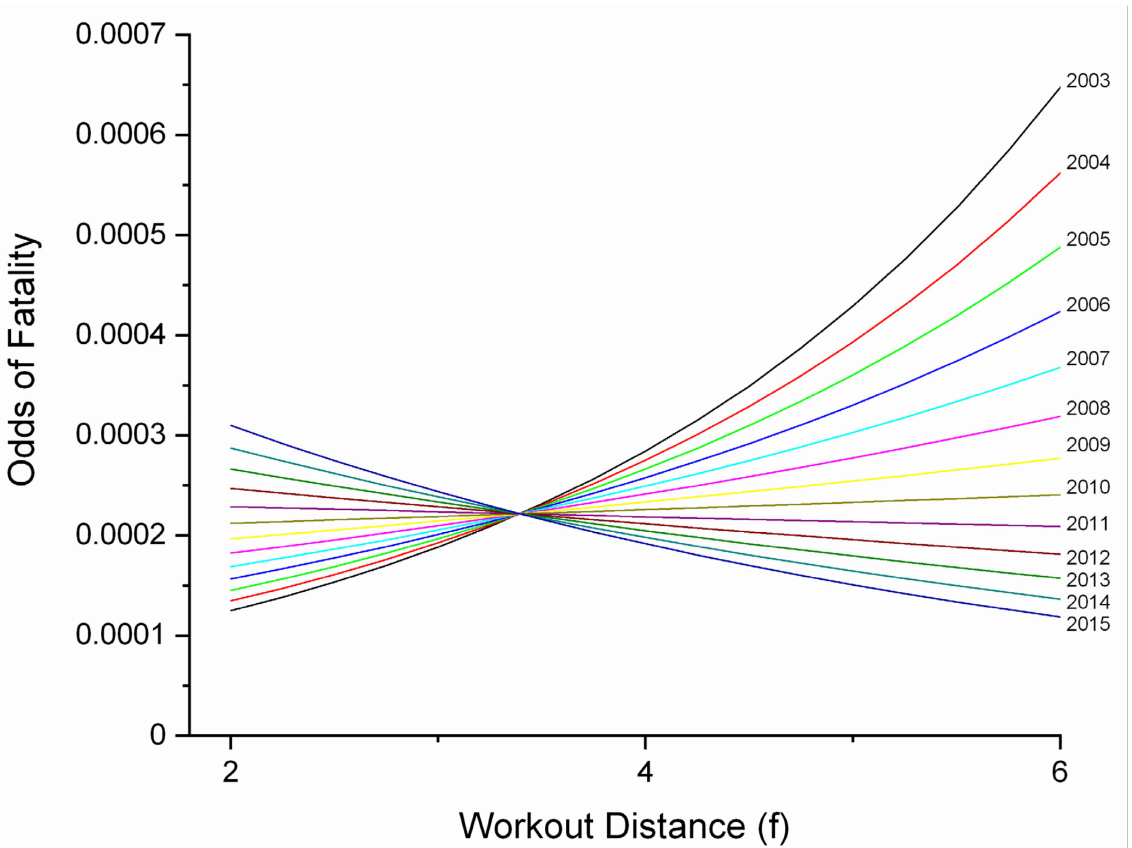
Figure 5. Odds of fatality by year (YEAR) and workout distance (DIST) for Ontario Thoroughbred racehorses for the period 2003–2015, unit of interest—workout work-event. The graph describes the interaction DIST*YEAR identified during multivariable logistic regression modelling of workout event fatalities. Fatality increased with workout distance early in the study period, but this effect disappeared by 2010, after which there was a reduction in fatality with increasing distance. Liability at 2f (mainly involving two-year-old horses) increased over the same period.